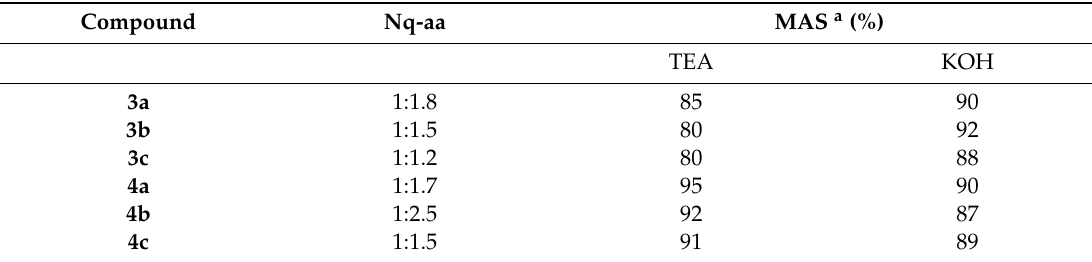
Figure 1. Preparation of 3 a – c and 4 a – c derivatives. Table 1. Reaction conditions to prepare 3 a – c and 4 a – c derivatives.